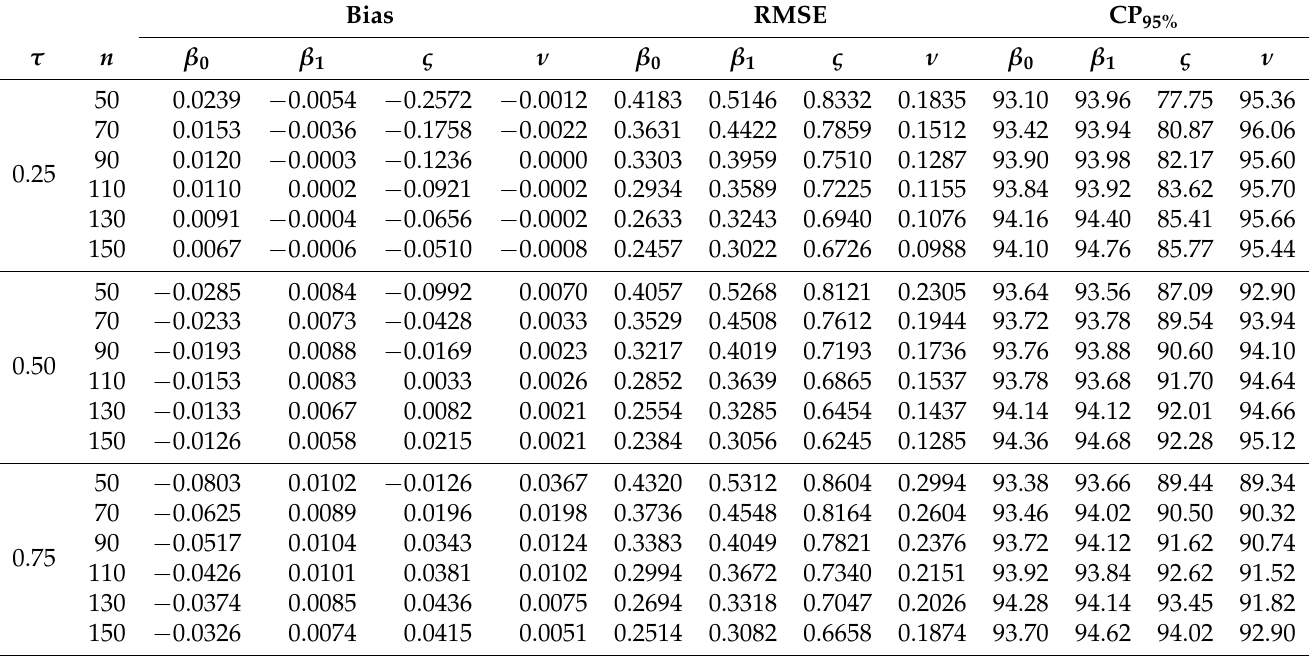
Table 6. Empirical RMSE, bias, and 95% CP (true values: β 0 = 0.50, β 1 = 0.50, ς = 1.50, and ν = 1.00) of the ML estimator for the indicated parameter with simulated